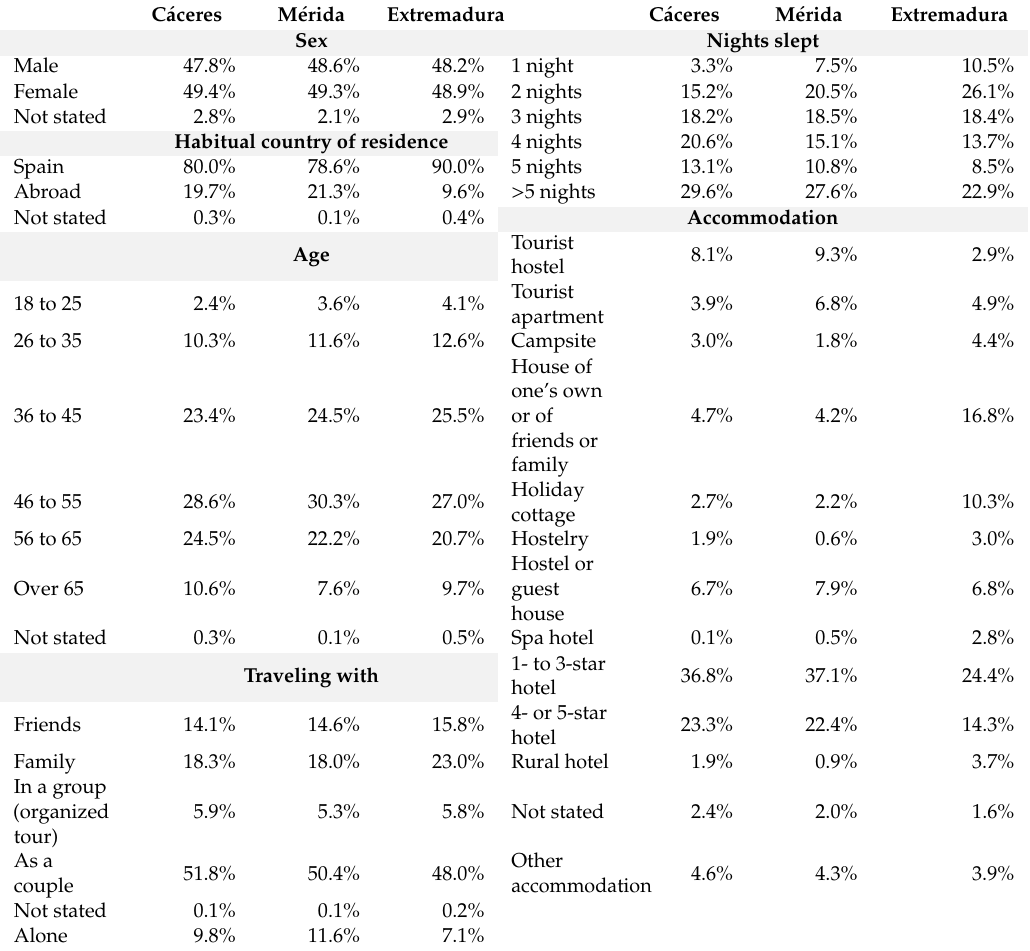
Table 3. Profile of generic